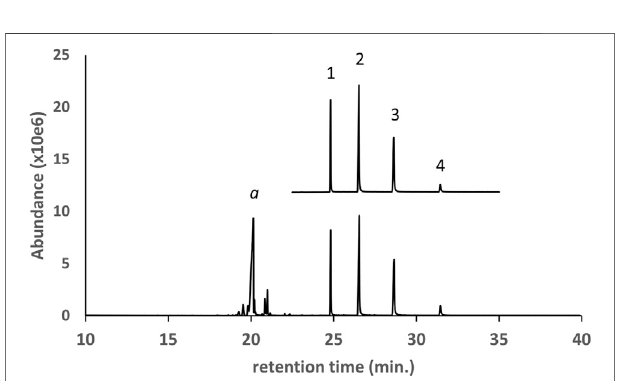
FIGURE2| GC-MSchromatogramforad9THCvapingliquid(peaklabel a, lower trace ) in which medium chain triglycerides (MCTs) were identi fi ed. The established MCT oil reference sample ( upper trace , expanded scale, offset) is shown for comparison. The triglycerides were identi fi ed as follows: 1- trioctanoin; 2- dioctanoyl/monodecanoyl triglyceride; 3- monooctanoyl/didecanoyl triglyceride; and 4- tridecanoin.